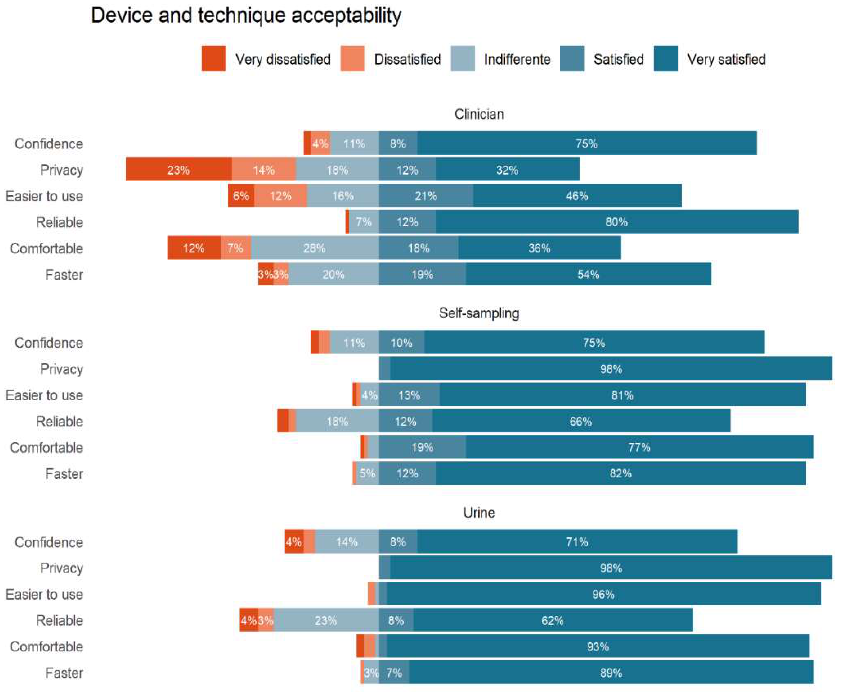
Figure 1. Device and technique acceptability.